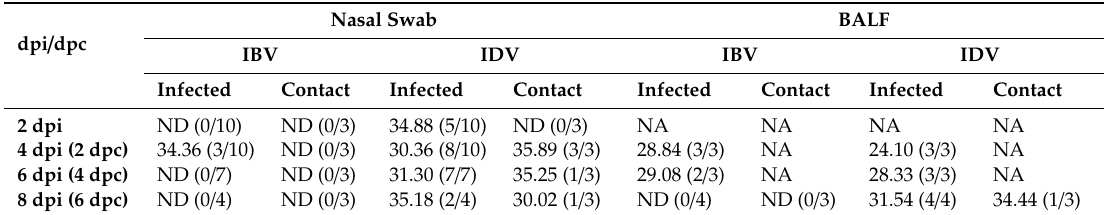
Table 1. RT-PCR Ct values of the nasal swab and bronchoalveolar lavage fluid (BALF) samples from pigs infected with either IBV or IDV and from contact pigs.